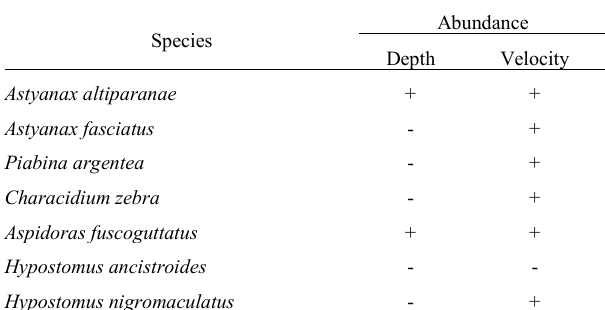
Table 2. Transferability test of HSC from forested to deforested streams. The + sign indicates that the HSC developed for forested streams was able to predict the abundance of a given species in deforested streams, and the - sign indicates the